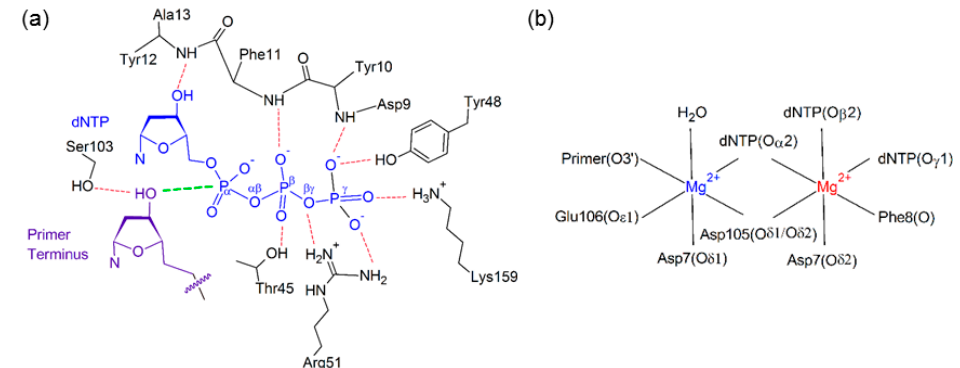
Figure 3. ( a ) Hydrogen-bonding interactions with the dNTP (blue) and primer terminus (purple), with the reaction distance shown in green; ( b ) Active site coordination of the catalytic (blue) and binding (red) Mg 2+ ions. Table 1. Percent occupancies for hydrogen-bonding interactions between the dNTP and active site residues a .